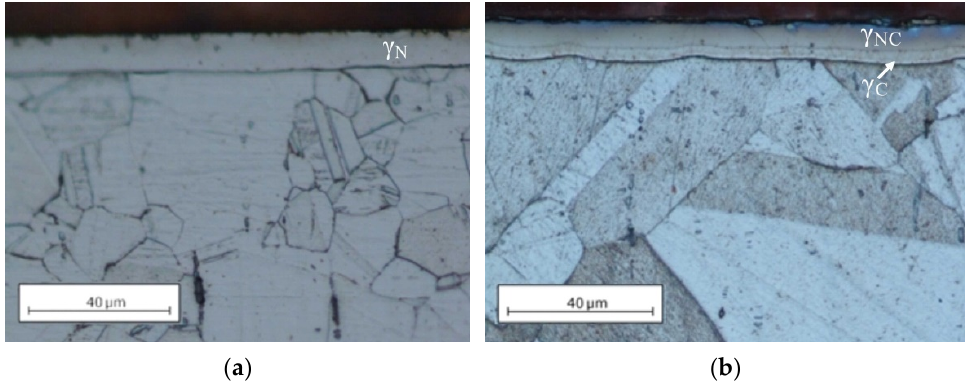
Figure 1. Microstructure of the ASPN (active screen plasma nitriding) ( a ) and ASPNC (nitrocarburising) ( b ) layers on AISI 316L steel.